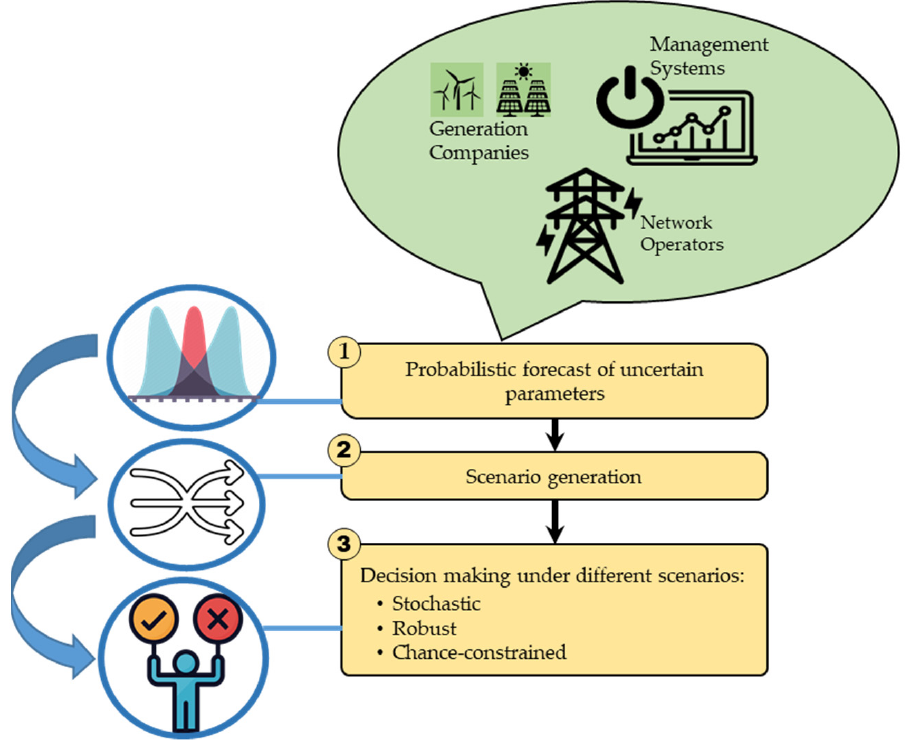
Figure 1. Decision-making steps in a smart grid environment.